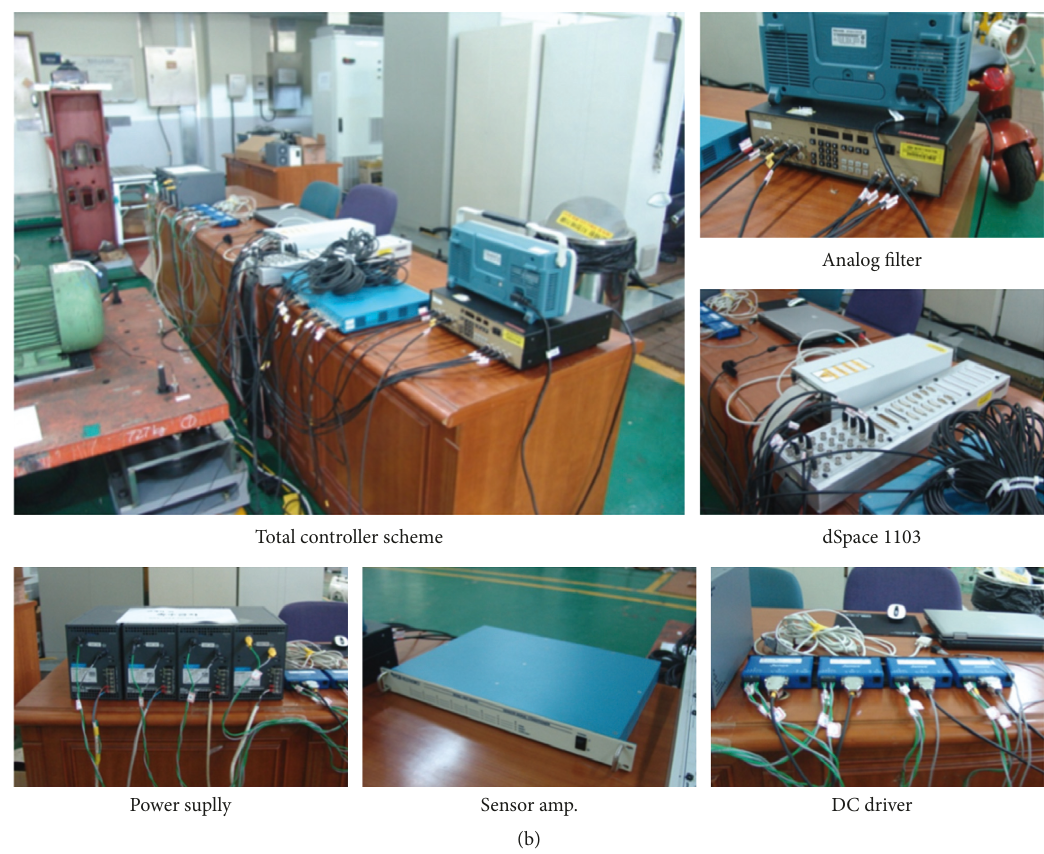
Figure 17: Experimental setup for 7-DOF system with electromagnetic hybrid mount. (a) Overall experimental setup for 7-DOF system. (b) Components for